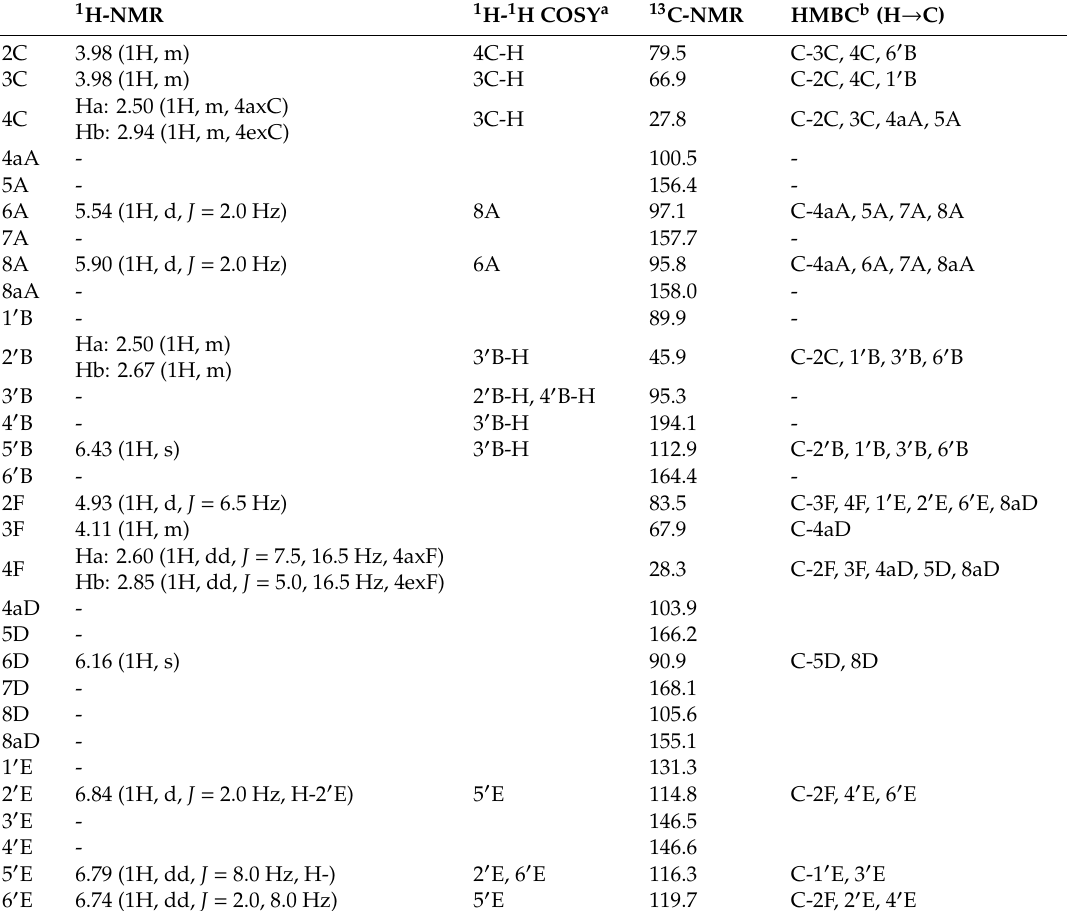
Table 2. 600 MHz 1 H-NMR and 150 MHz 13 C-NMR data of compound 5 in Methanol- d 4